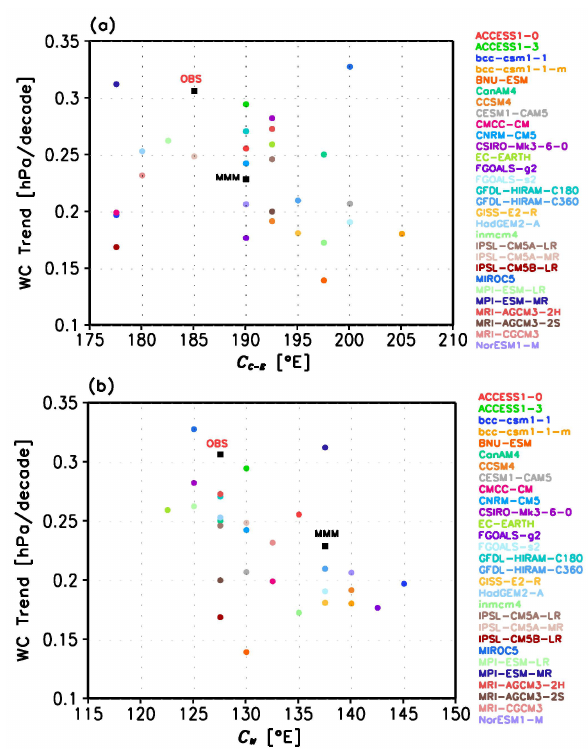
Figure 3. Scatter diagrams of the WC trend versus the longitudinal positions of the center of the ENSO-related PRCPA in the ( a ) central-to-eastern tropical Pacific (5 ˝ S–5 ˝ N) and the ( b ) western tropical Pacific (0–20 ˝ N) regions in the 29 models, together with those in the observations and the MMM.